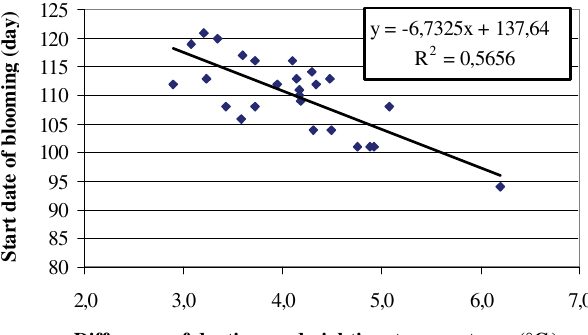
Figure 5. Relationship between the average difference of daytime and nightime temperatures thirty days prior to blooming start and the start date of blooming at “Debreceni bôtermô” cultivar (Újfehértó 1983–2008)